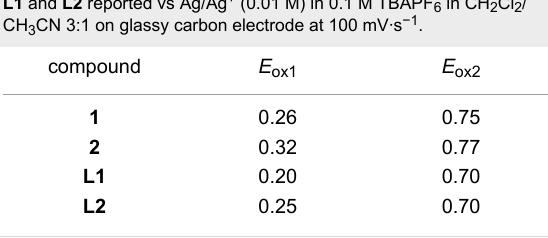
Table 3: Apparent redox potentials (V) of molecular compounds 1, 2, L1 and L2 reported vs Ag/Ag + (0.01 M) in 0.1 M TBAPF 6 in CH 2 Cl 2